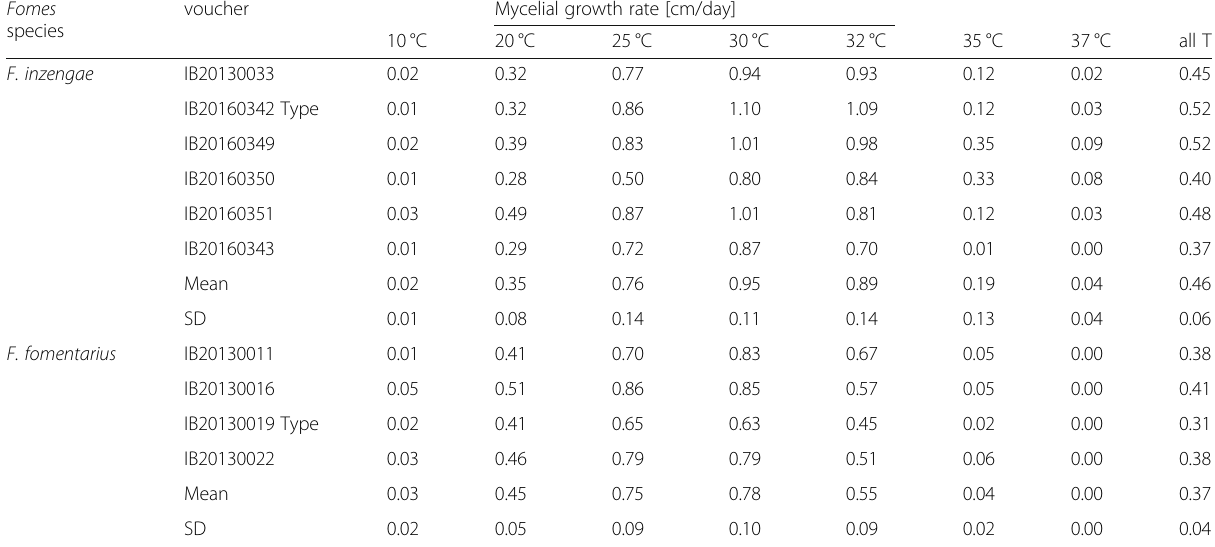
Table 2 Effects of temperature on mycelial growth (cm/day) of ten Fomes strains cultivated on 3% MEA. The mycelial growth rate per day [cm/day] was calculated for the first 7 days of incubation Fomes voucher Mycelial growth rate [cm/day] species